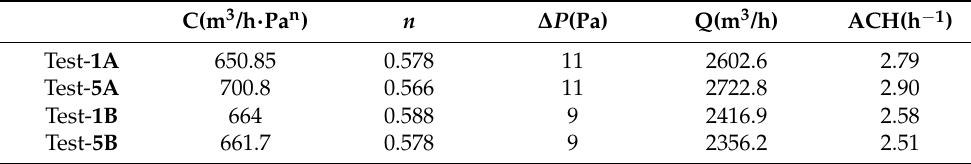
Table 7. Calculated air leakage rate for the selected